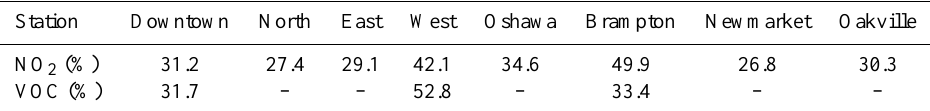
Table 2. The percentage difference between 2004 and 2012 NO 2 and VOC concentrations (ppb) at all stations monitored (Junction was not included as monitoring stopped in